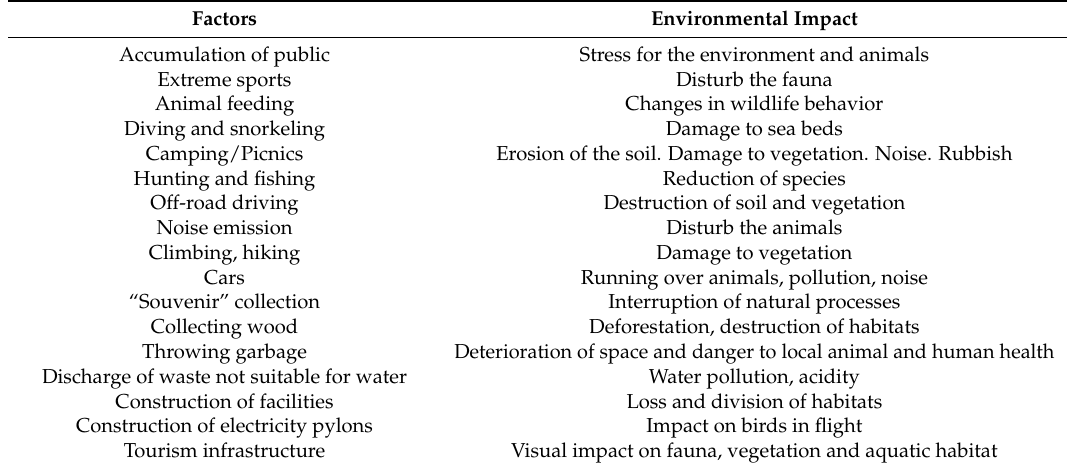
Table 1. Tourism factors and their impact on the